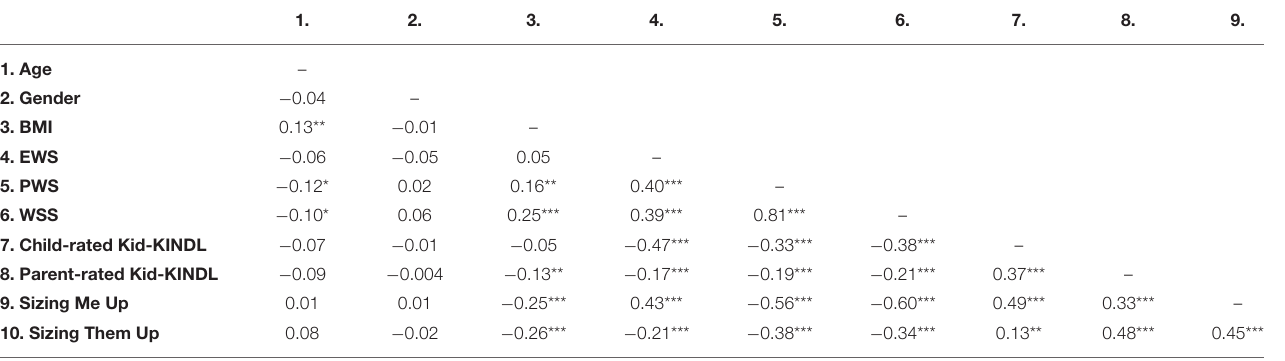
TABLE 4 | Pearson correlation matrix in the studied variables.